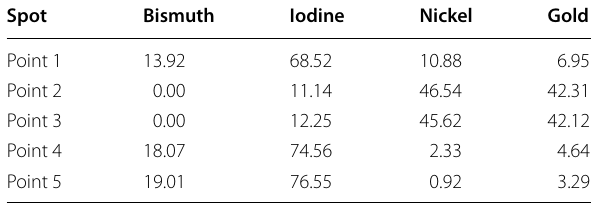
Table 2 Elemental distribution (atomic %) of the individual elements observed on a particular spot on (CH NH ) Bi I /NiO film shown in Fig. 4b 3 3 3 2 9